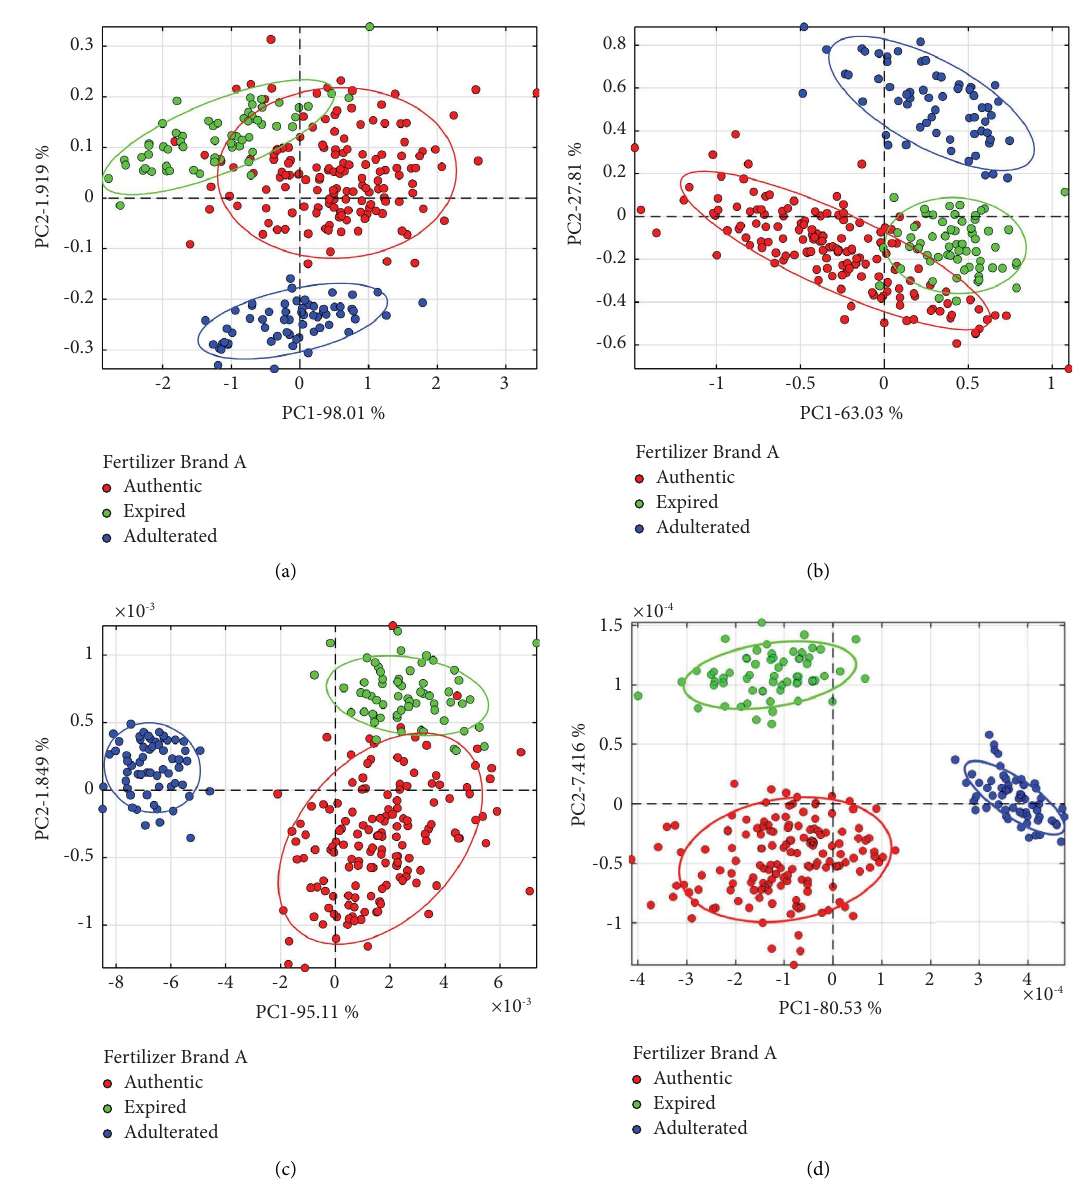
Figure 3: PCA score plot: (a) raw, (b) SNV, (c) SGFD, and (d) SGSD of fertilizer brand